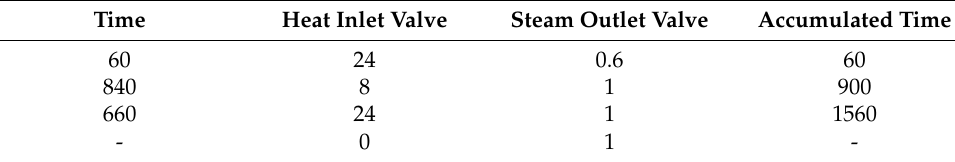
Table 4. Operating procedure decoded from the solution shown in Table